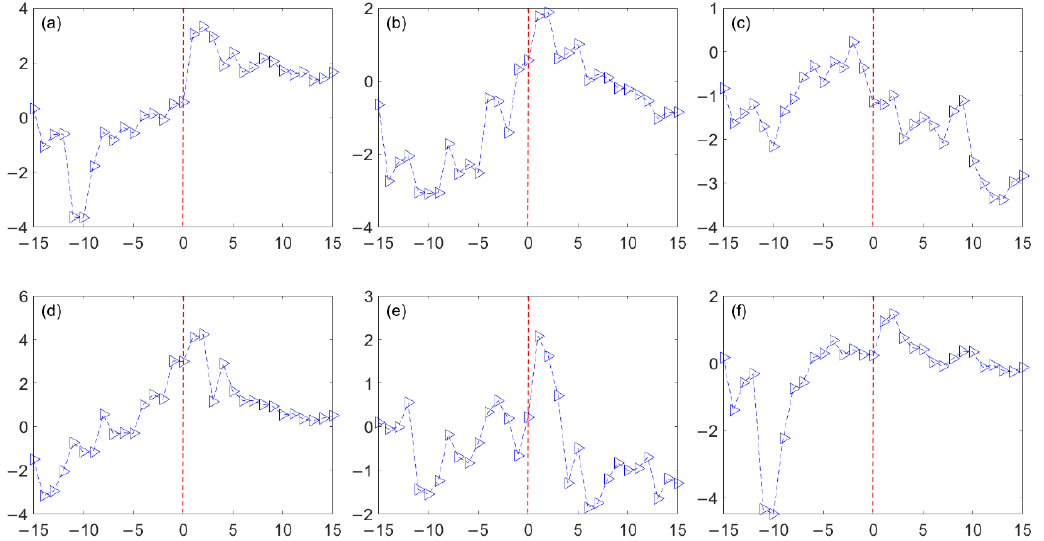
Figure 8. Strike of the event of the Sino–U.S. trade war B2 on the outlier of net spillover effect: ( a – f ) show the outlier of net spillover between the carbon market (CT) and oil (OPI), electricity (PI), steel (SI), chemicals (CI), non-ferrous metals (NFMI), and banking (BI) sectors, respectively.